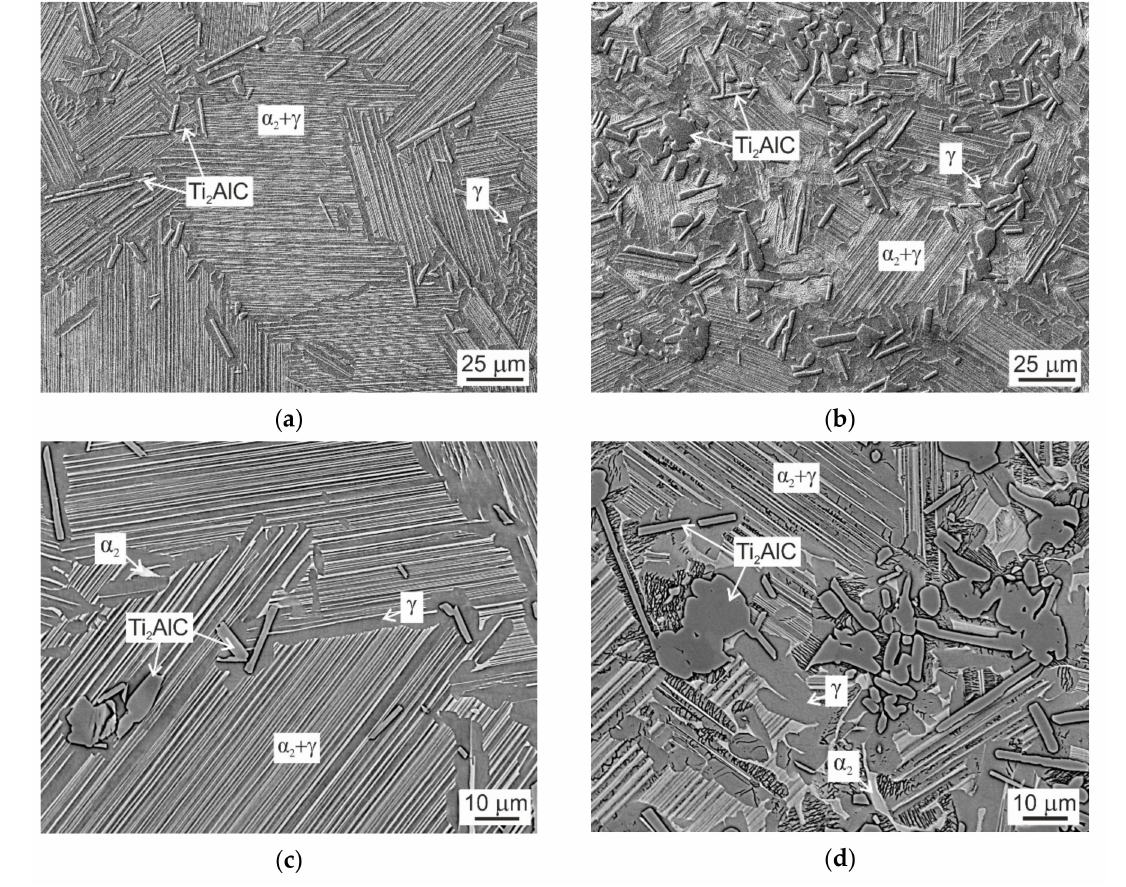
Figure 4. Micrographs showing the microstructure of C20 and C36 alloys after heat treatment: ( a ) Lamellar grain structure of HT C20 alloy, SEM; ( b ) Grain structure of HT C36 alloy, SEM; ( c ) Grain boundaries with γ phase, primary Ti 2 AlC particles and α 2 phase in HT C20 alloy, BSE; ( d ) Grain boundaries with γ phase, primary Ti 2 AlC particles and α 2 phase in HT C36 alloy,